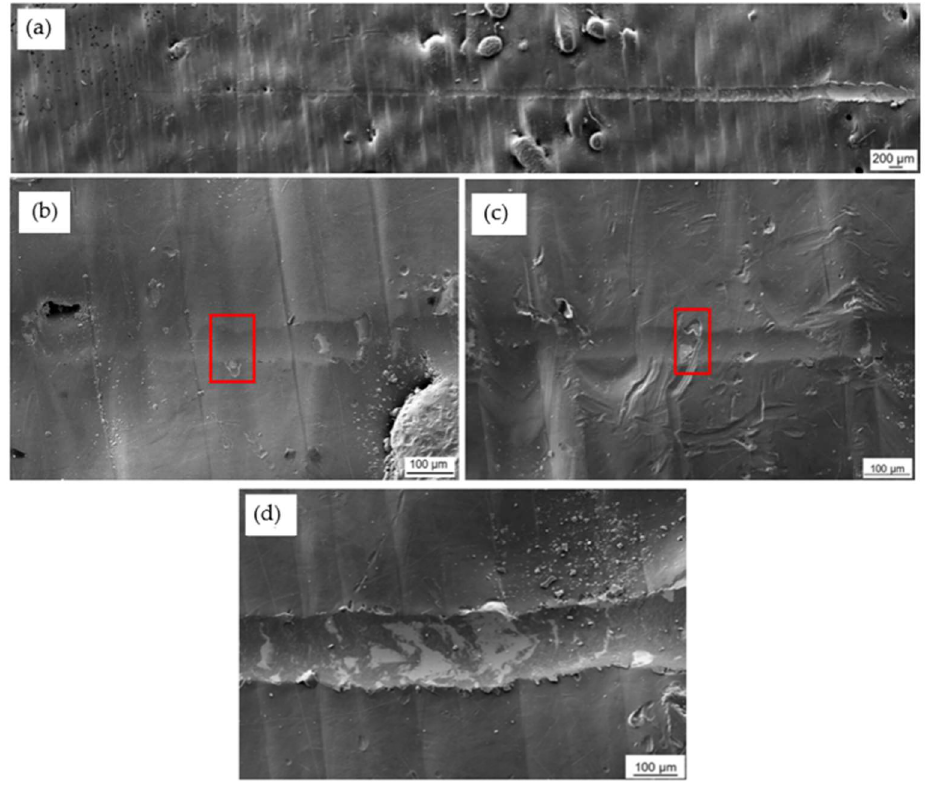
Figure 12. SEM topographical images of the wear scar morphology on the coated specimen: ( a ) Whole length of the wear scar ( b ) Red box showing location of L C2 ( c ) Red box showing location of L C3 and ( d ) Further delamination along the wear track.